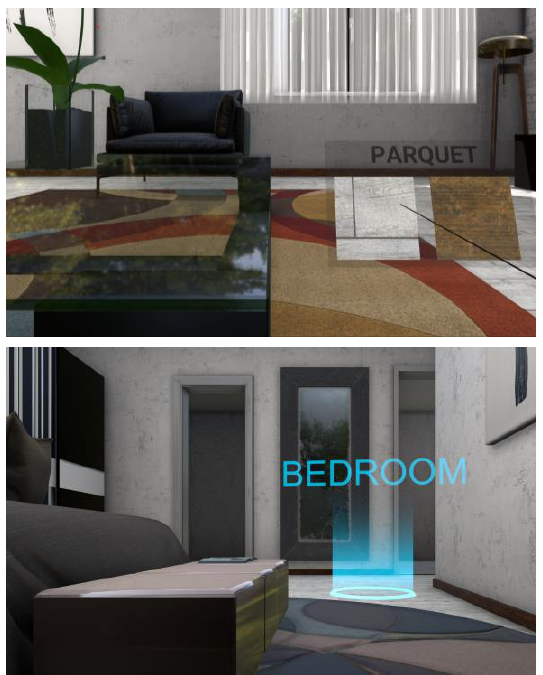
Figure 3. Graphical user interface to change material textures (upper). Teleporting point (bottom).